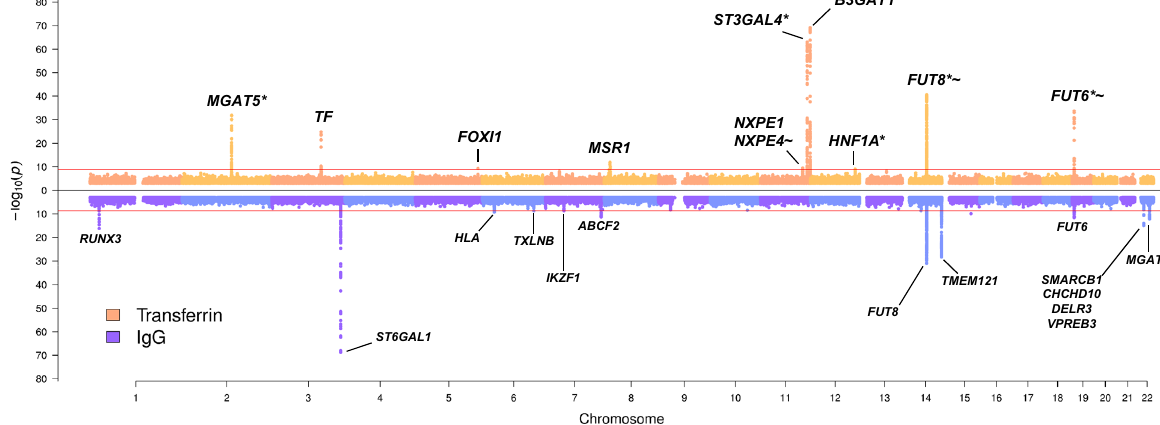
Fig. 1 Transferrin and IgG N-glycome GWAMA summary Miami plot. Miami plot pooling together meta-analysis results obtained across all 35 transferrin glycan traits at the top in orange, and across all 24 IgG glycan traits at the bottom in blue. The pooling was performed by selecting the lowest p value (y-axis) from all 35 (TF) or 24 (IgG) glycan traits for every genomic position (x axis). For transferrin N-glycome associations, '*' marks loci previously reported in total blood plasma N-glycome GWAS 22 – 25 , while '~' marks loci previously reported in IgG N-glycome GWAS 26 – 29 . The Bonferroni-corrected genome-wide signi fi cance threshold for the transferrin N-glycome meta-analysis (horizontal red line in the top part of the plot) corresponds to 1.43 × 10 − 9 , while Bonferroni-corrected genome-wide signi fi cance threshold for the IgG N-glycome meta-analysis (horizontal red line in the bottom part of the plot) corresponds to 2.08 × 10 − 9 . For simplicity, SNPs with p value > 1 × 10 − 3 are not plotted. Gene or sets of genes annotated for transferrin N-glycome loci have been prioritised in this study; gene or sets of genes annotated for IgG N-glycome loci are those prioritised by Klari ć et al. 26 . P values are derived from the two-sided Wald test with one degree of